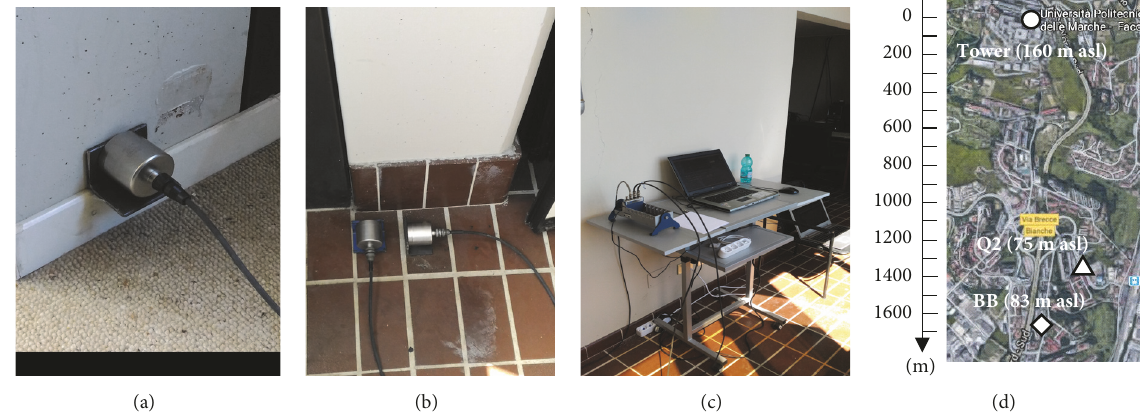
Figure 7: (a) Accelerometer at position Bx; (b) accelerometers at positions Ax and Ay; (c) acquisition station.